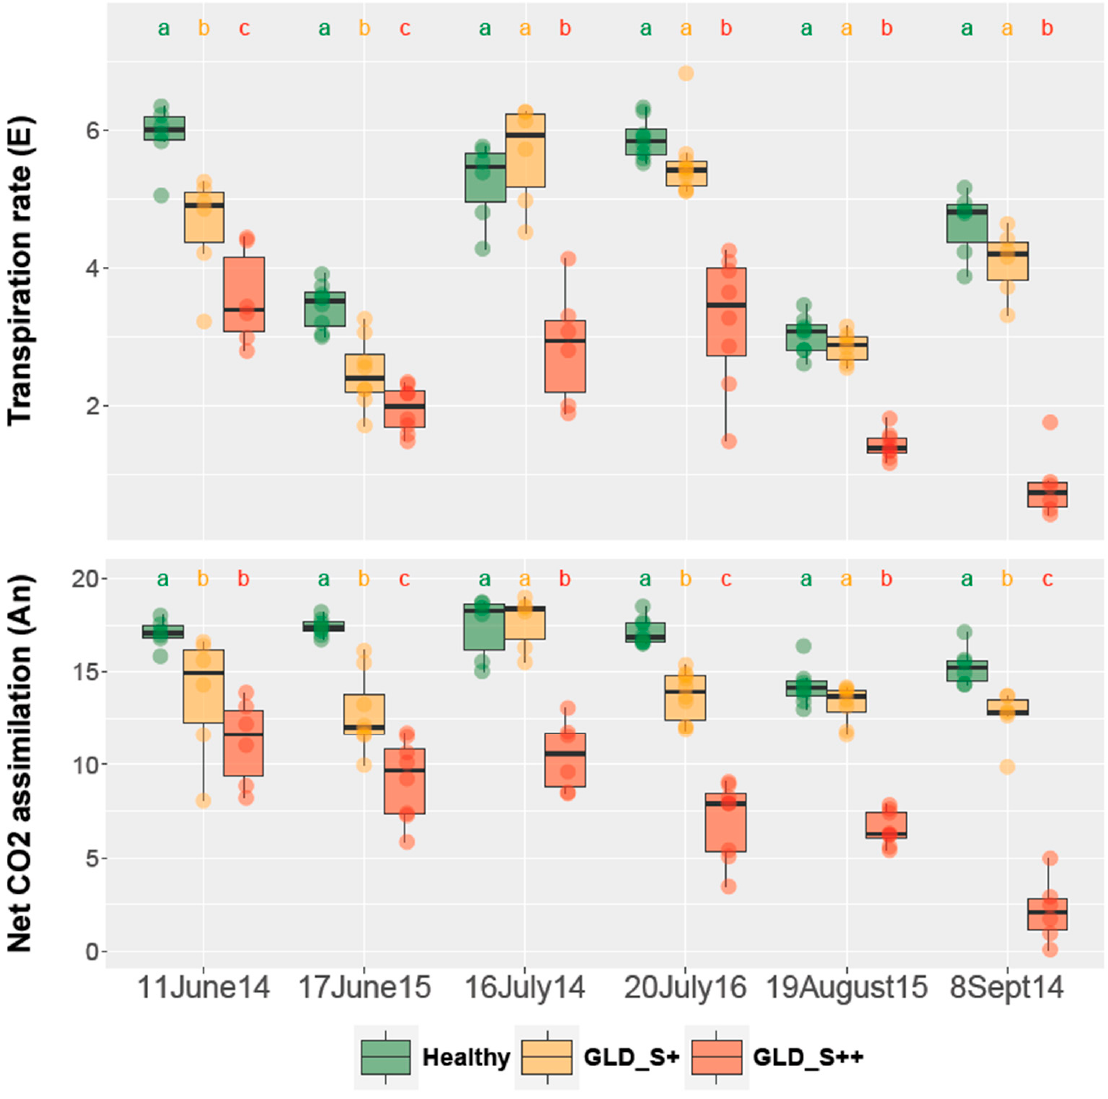
Figure 4. Effect of grapevine leafroll disease on gas exchange parameters in Vitis vinifera cv. Pinot noir on rootstock 5BB. Transpiration rate is expressed as mmol H 2 O m − 2 s − 1 , net photosynthesis (AN) as µmol CO 2 m − 2 s − 1 . Measurements were recorded on six different days over three seasons. Means were denoted by different letters (a, b, and c) when they differ significantly at p < 0.05 using Ducan’s new multiple range test. N = 8 per treatment and date. Healthy: symptomless; GLD_S+: grapevine leafroll disease causing mild symptoms; GLD_S++: grapevine leafroll disease causing severe symp- toms.